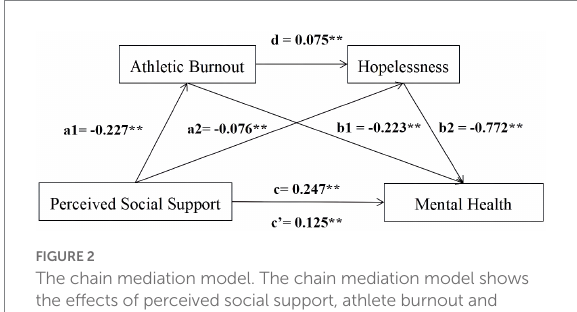
FIGURE 2 The chain mediation model. The chain mediation model shows the effects of perceived social support, athlete burnout and hopelessness on mental health. N = 674. ** p <